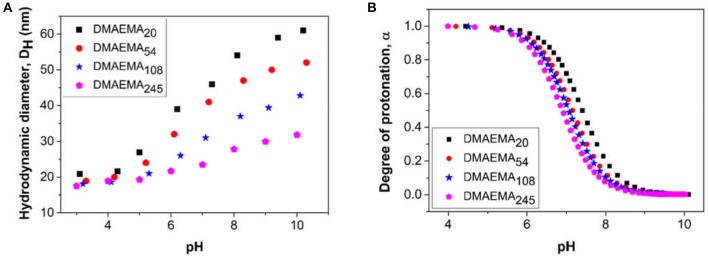
Changes in (A) hydrodynamic diameter and (B) degree of polymer protonation as a function of solution pH for the four diblock copolymers prepared at a concentration of 1,000 ppm (above the CMC). The polymer solutions are prepared in the presence of 0.01 M KNO3, (T = 25°C). The pKaof the copolymers obtained are; DMAEMA20 = 7.41, DMAEMA54 = 7.16, DMAEMA108 = 7.08, and DMAEMA245 = 6.92.